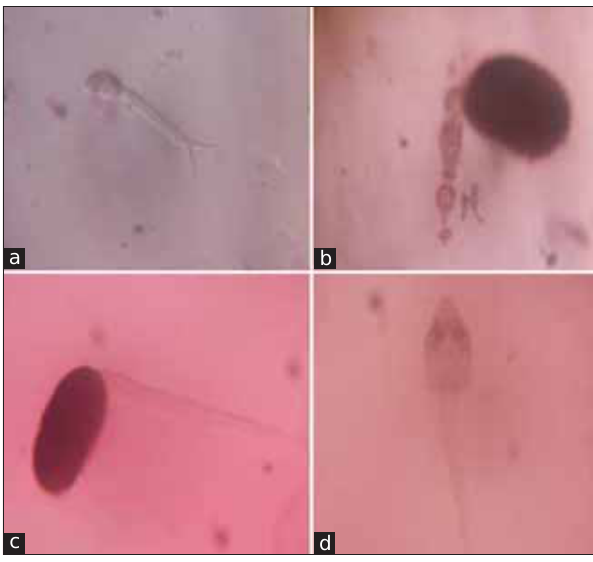
Figure-1: Different types of cercariae found in snail’s